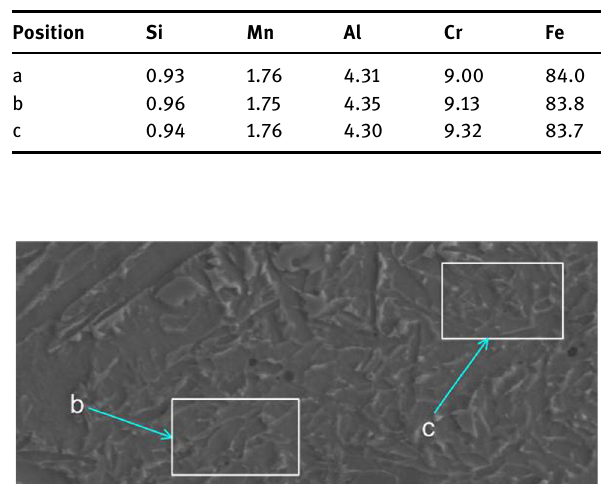
Table 4: SEM - EDS analyses of marked areas in the MP weld metal in